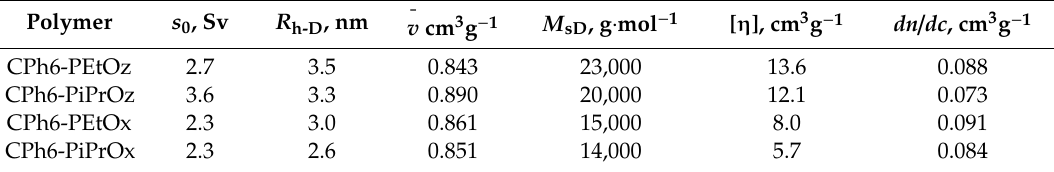
Table 1. Hydrodynamic characteristics and molar masses of investigated polymer